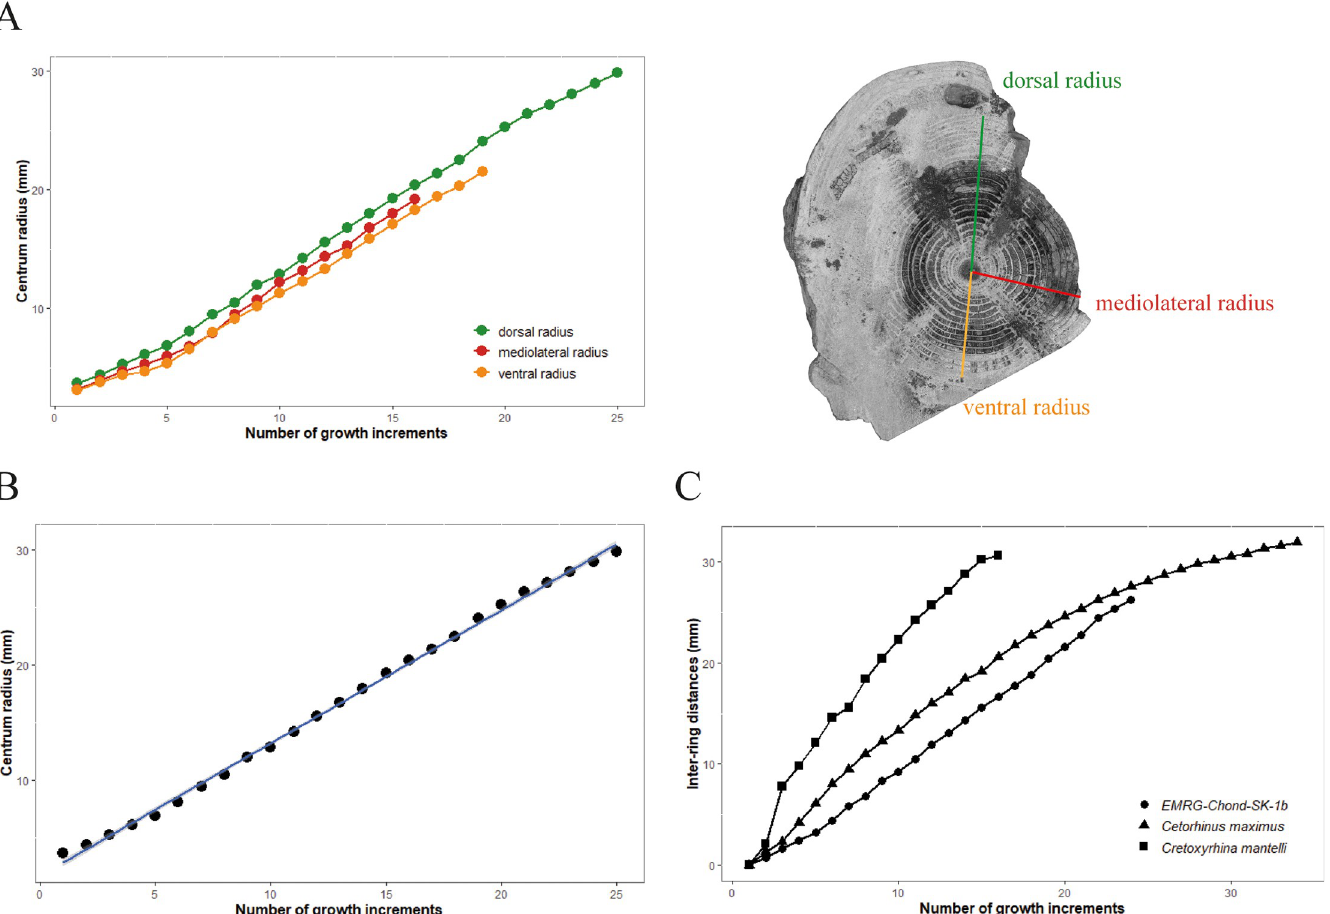
Fig 5. Growth ring profile of EMRG-Chond-SK-1b. (A) centrum size profiles of EMRG-Chond-SK-1b follow the same trend for radii in dorsal, ventral and mediolateral direction. (B) data points of the centrum size profile closely follow a linear function. (C) growth ring distances of EMRG-Chond-SK-1b compared to † Cretoxyrhina mantelli [10] and Cetorhinus maximus